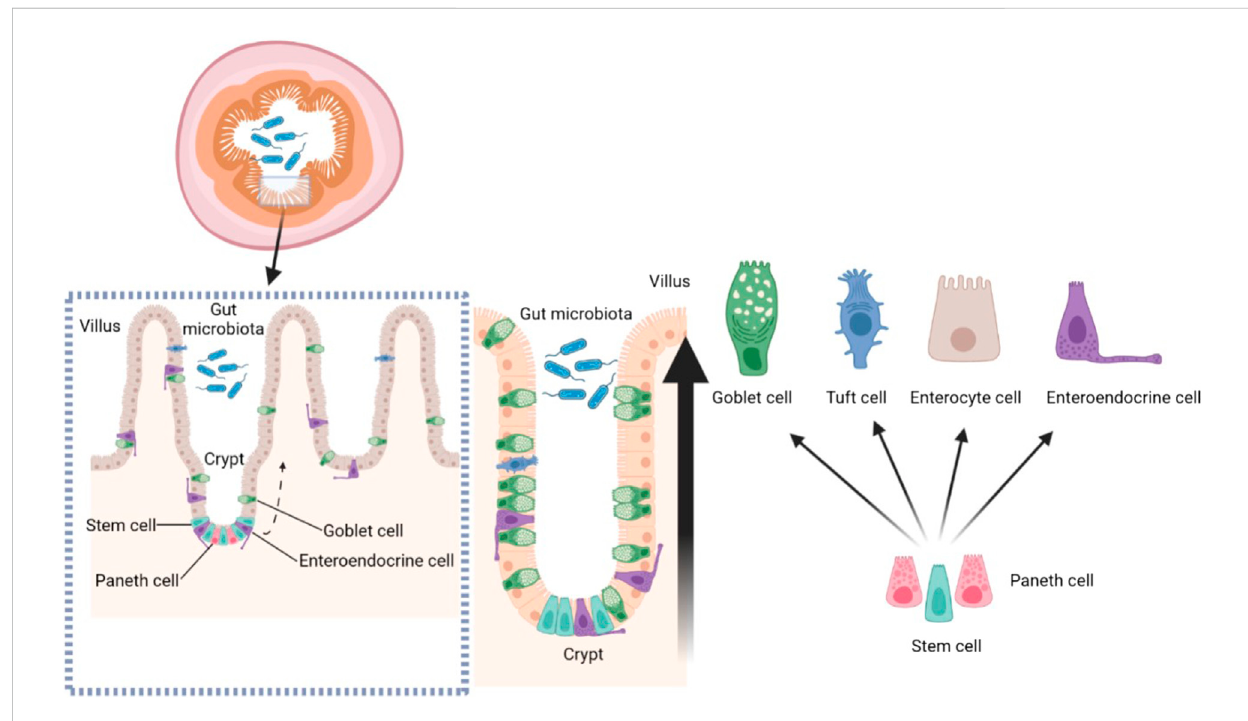
FIGURE 2 The structure of intestinal